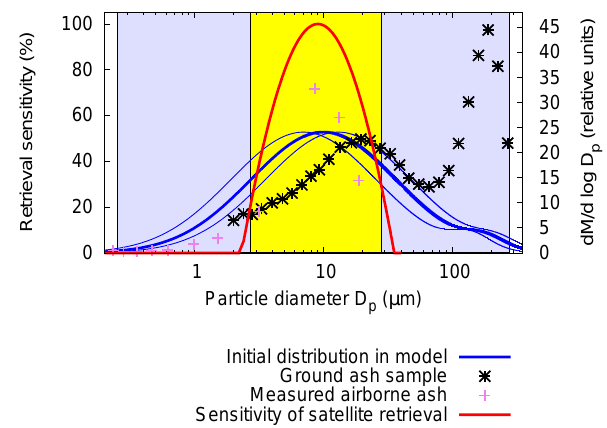
Fig. 1. Ash mass size distributions. Particle size distributions mea- sured in an ash sample collected at the ground at a distance of 60km from the vent at 11:30 on 15 April 2010 (black asterisks) (see http: //www.earthice.hi.is/page/ies EYJO2010 Grain) and by the DLR Falcon aircraft 450km downwind of the vent at 15:00UTC on 2 May 2010 as described by Schumann et al. (2011) (violet plusses). The blue lines are a fit through the initial size distribution required to match the ground sample distribution with the model (thick blue line) as well as shifted distributions used for sensitivity analyses (thin blue lines). The red line shows the sensitivity of the SEVIRI and IASI satellite retrievals to ash particle size. The yellow and grey boxes indicate the size range used for the inverse modeling and for other modeling, respectively. Only the ash mass in the yellow size range (ca. 70% of the total mass for the fitted reference distribution) is constrained by the satellite